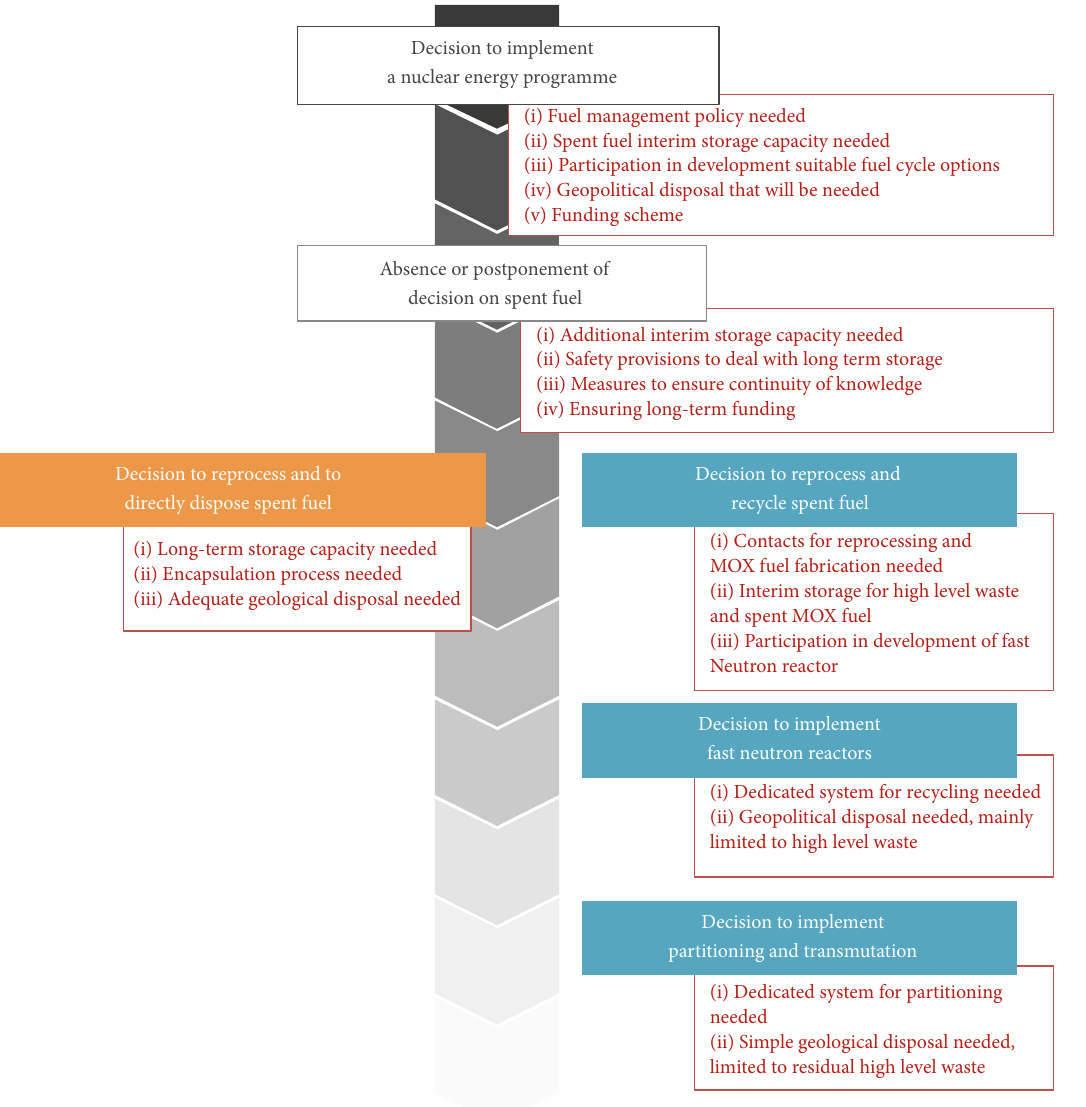
Figure 1: Key decisions and main consequences with respect to SNF as given in